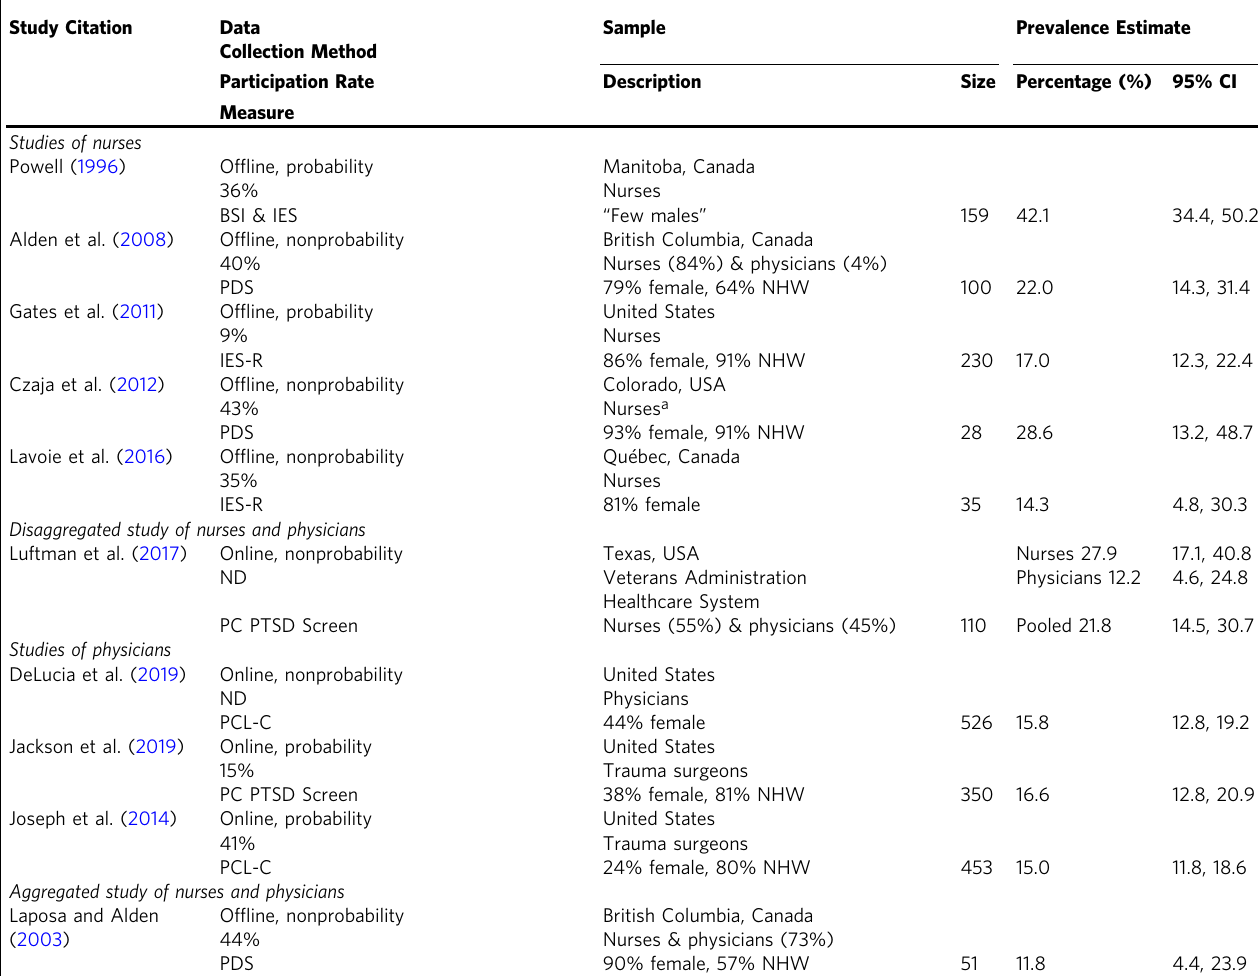
Table 1 Posttraumatic stress disorder prevalence among emergency department personnel: Characteristics and outcomes of 10